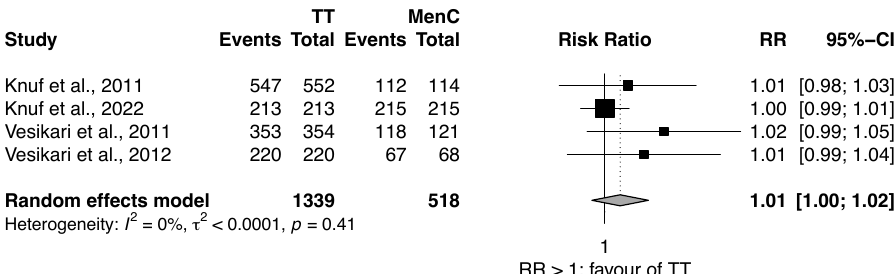
Some concerns + Low D4: Bias in measurement of the outcome.